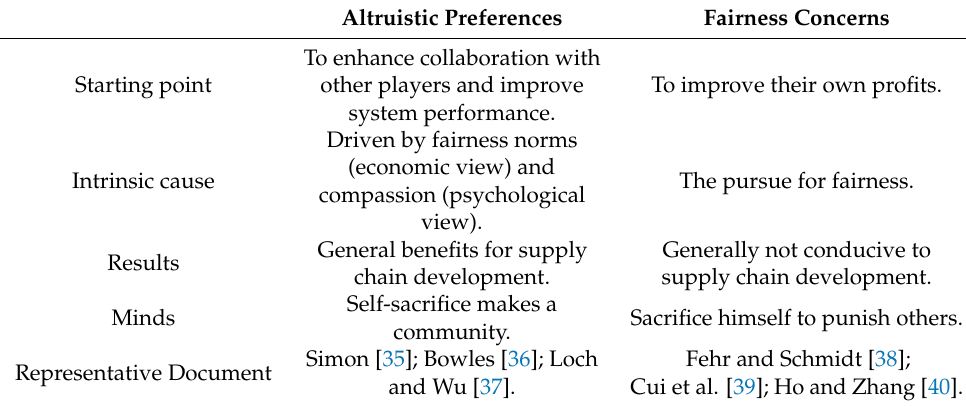
Table 1. Differences between altruistic preferences and fairness concerns. Altruistic Preferences Fairness Concerns To enhance collaboration Starting point